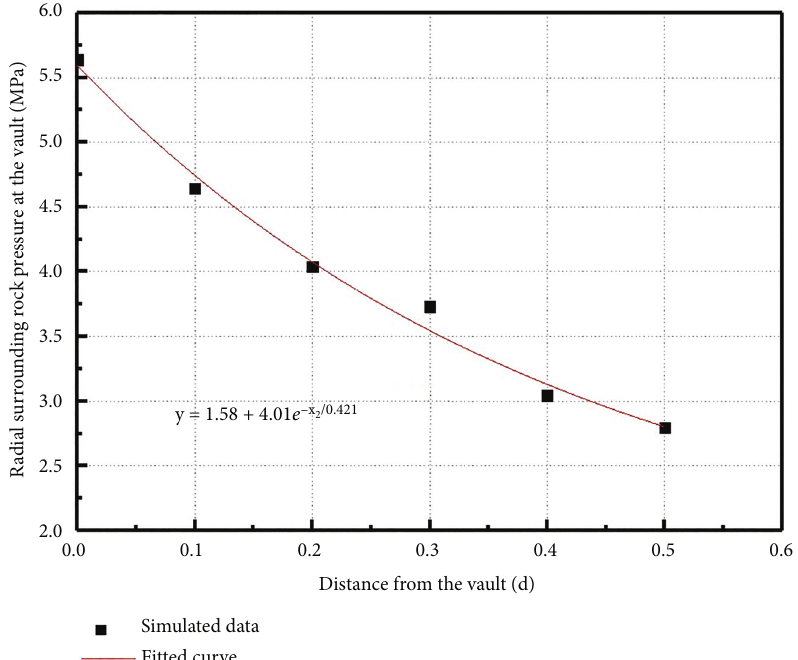
Figure 9: Fitting curve of the relationship between the surrounding rock pressure of the vault and the weak interlayer at di ff erent